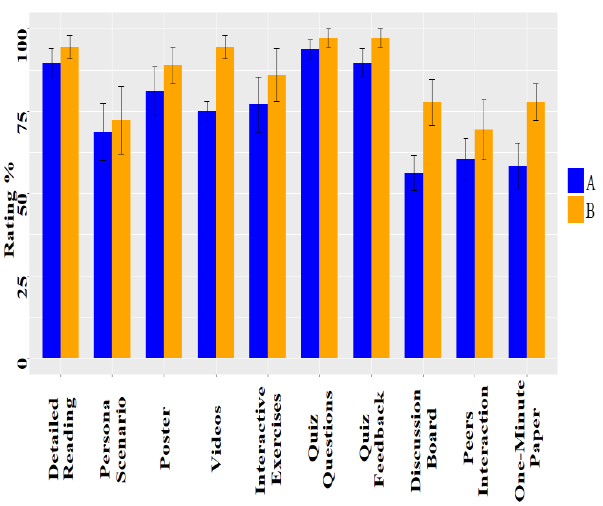
Figure 4 . Effectiveness of the e-Learning Resources Figure 5 . Rating of the Usability of the Online